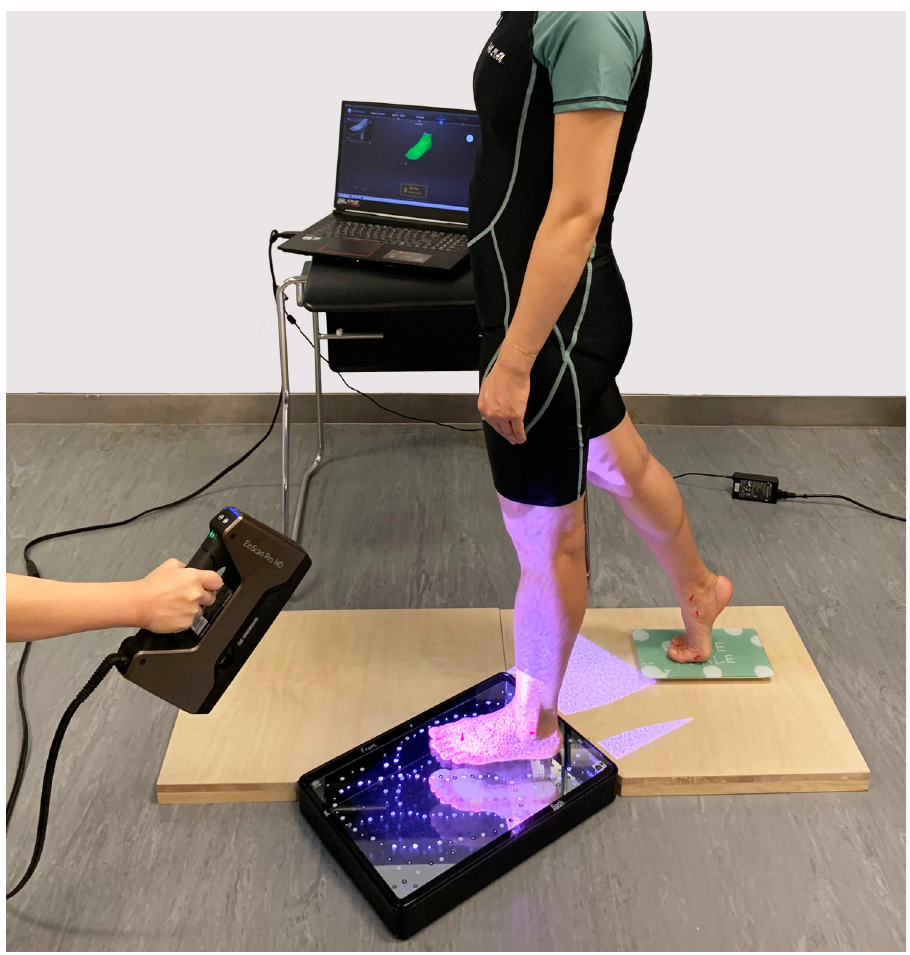
Fig 1. EinScan Pro HD 3D handheld scanner with foot